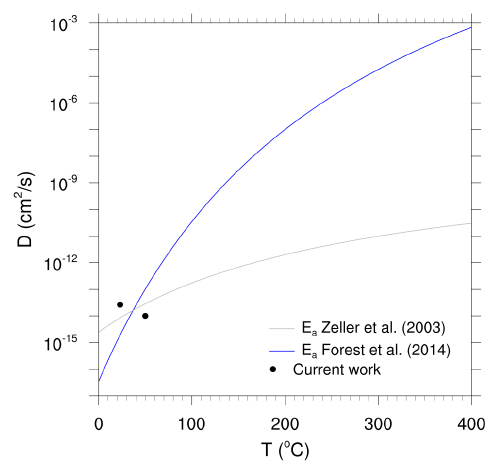
Figure 10. Arrhenius theoretical curves using two different activation